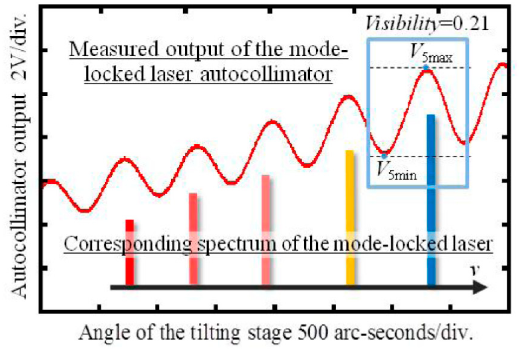
Figure 5. Variation of the reading output of the femtosecond laser autocollimator due to the angular displacement of the grating reflector [55].